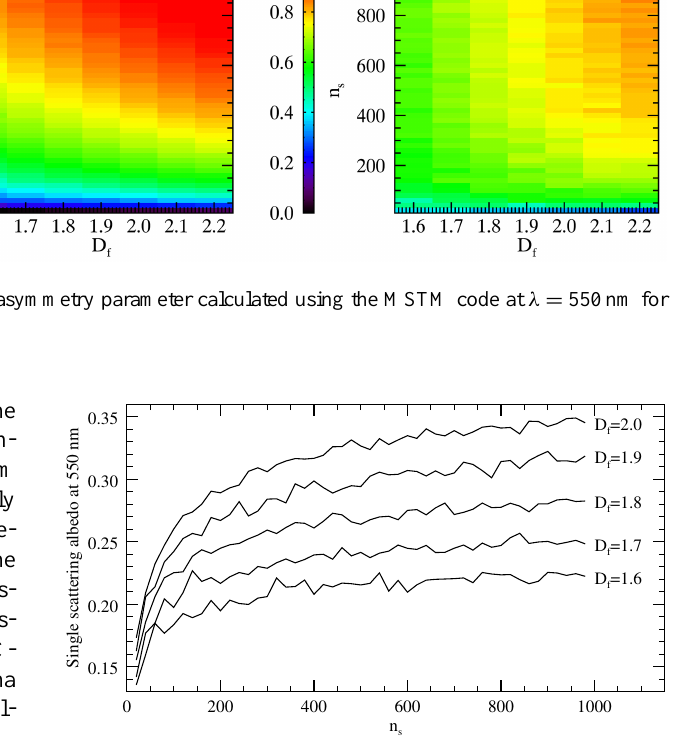
Figure 3. The SSA of BCFAs at λ = 550nm as a function of n s and D f . The most likely values of D f would be from 1 . 7 to 1 . 8, where the SSA values are between 0 . 2 and 0 .